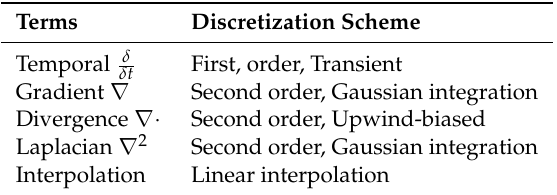
Table 1. Numerical schemes used for the present